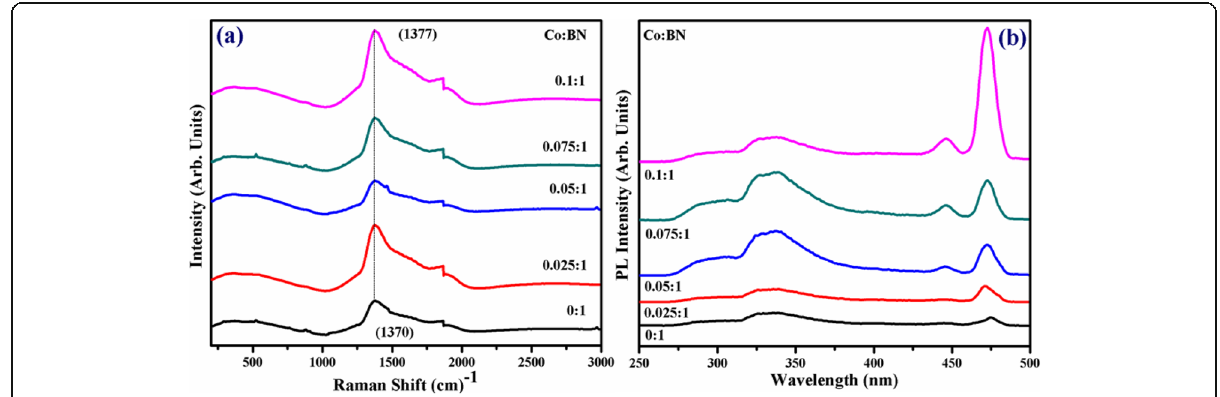
Fig. 4 a Raman spectra of control and doped BN-NS. b PL